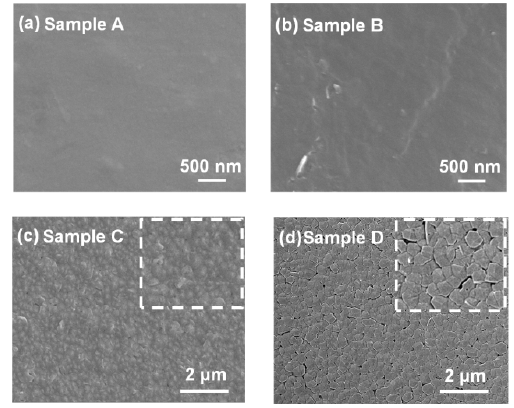
Figure 3. Scanning electron microscopy (SEM) surface image of GaN films grown on different substrates: ( a ) GaN/sapphire template (sample A); ( b ) sapphire (sample B); ( c ) Si(111) (sample C); ( d ) Si(100) (sample D).